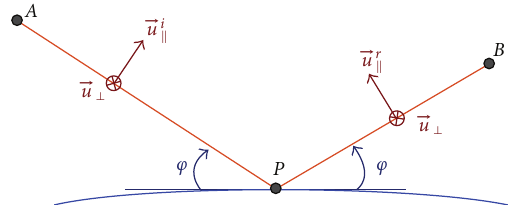
Figure 7: Unit vector definition for